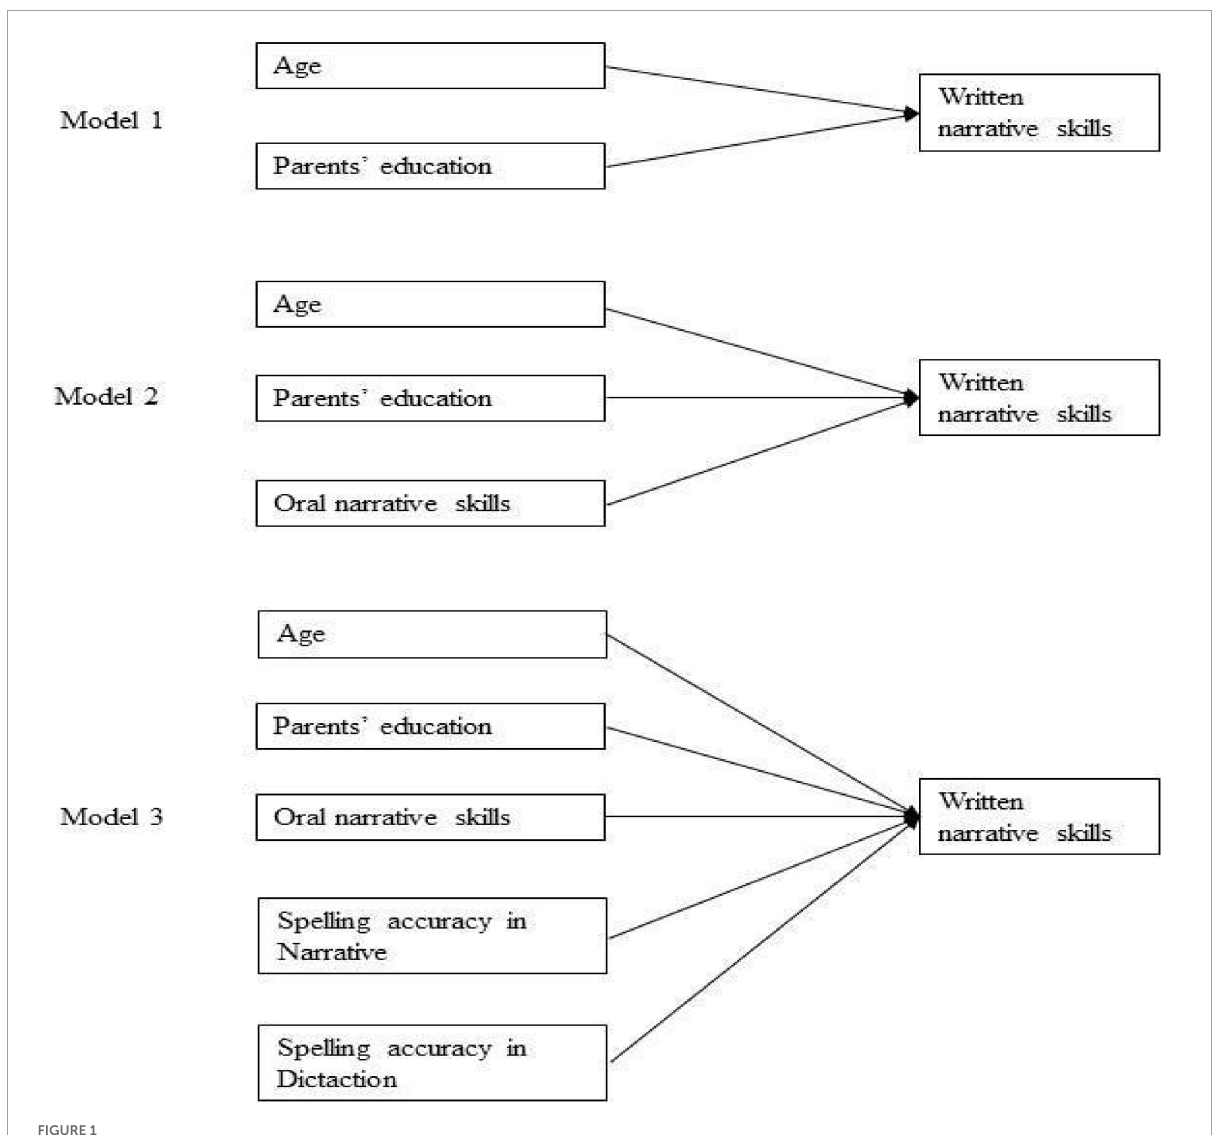
FIGURE1 Hierarchical regression models.